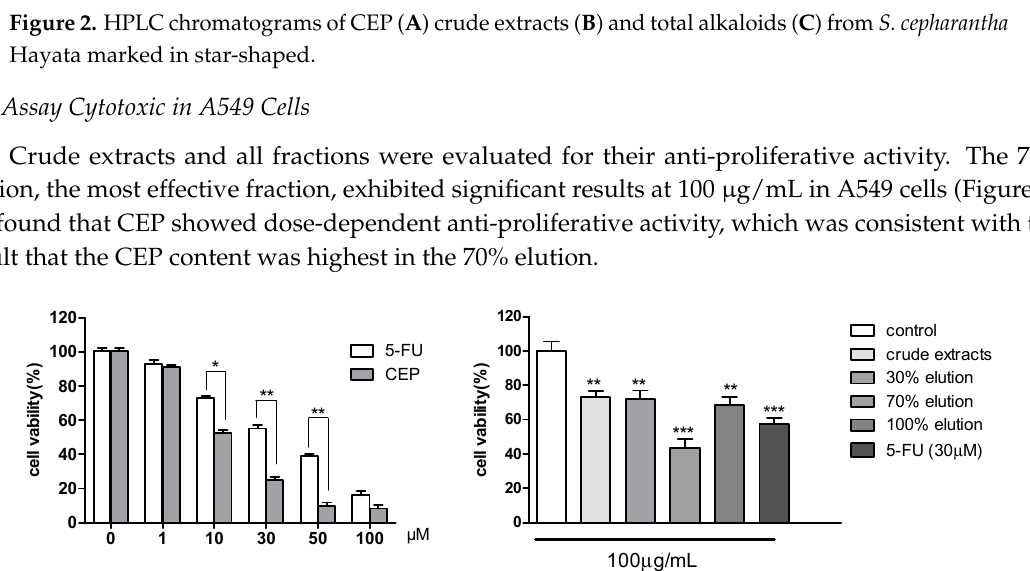
Figure 3. Cytotoxicity assay of CEP, crude extracts, and elutions by MTT in A549 cells. Results are the mean ± SD from three independent experiments. Significance: * p < 0.05, ** p < 0.01, and *** p < 0.001 compared to control groups.